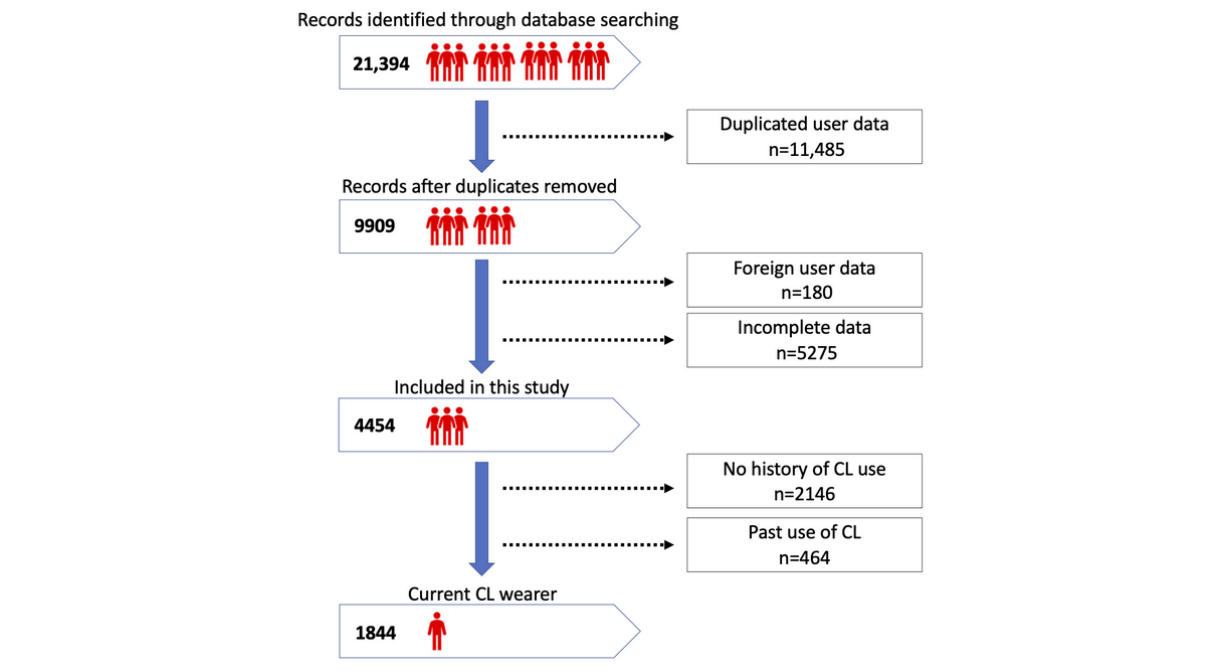
Figure 2. Flow chart of the enrollment process used in this study. CL: contact